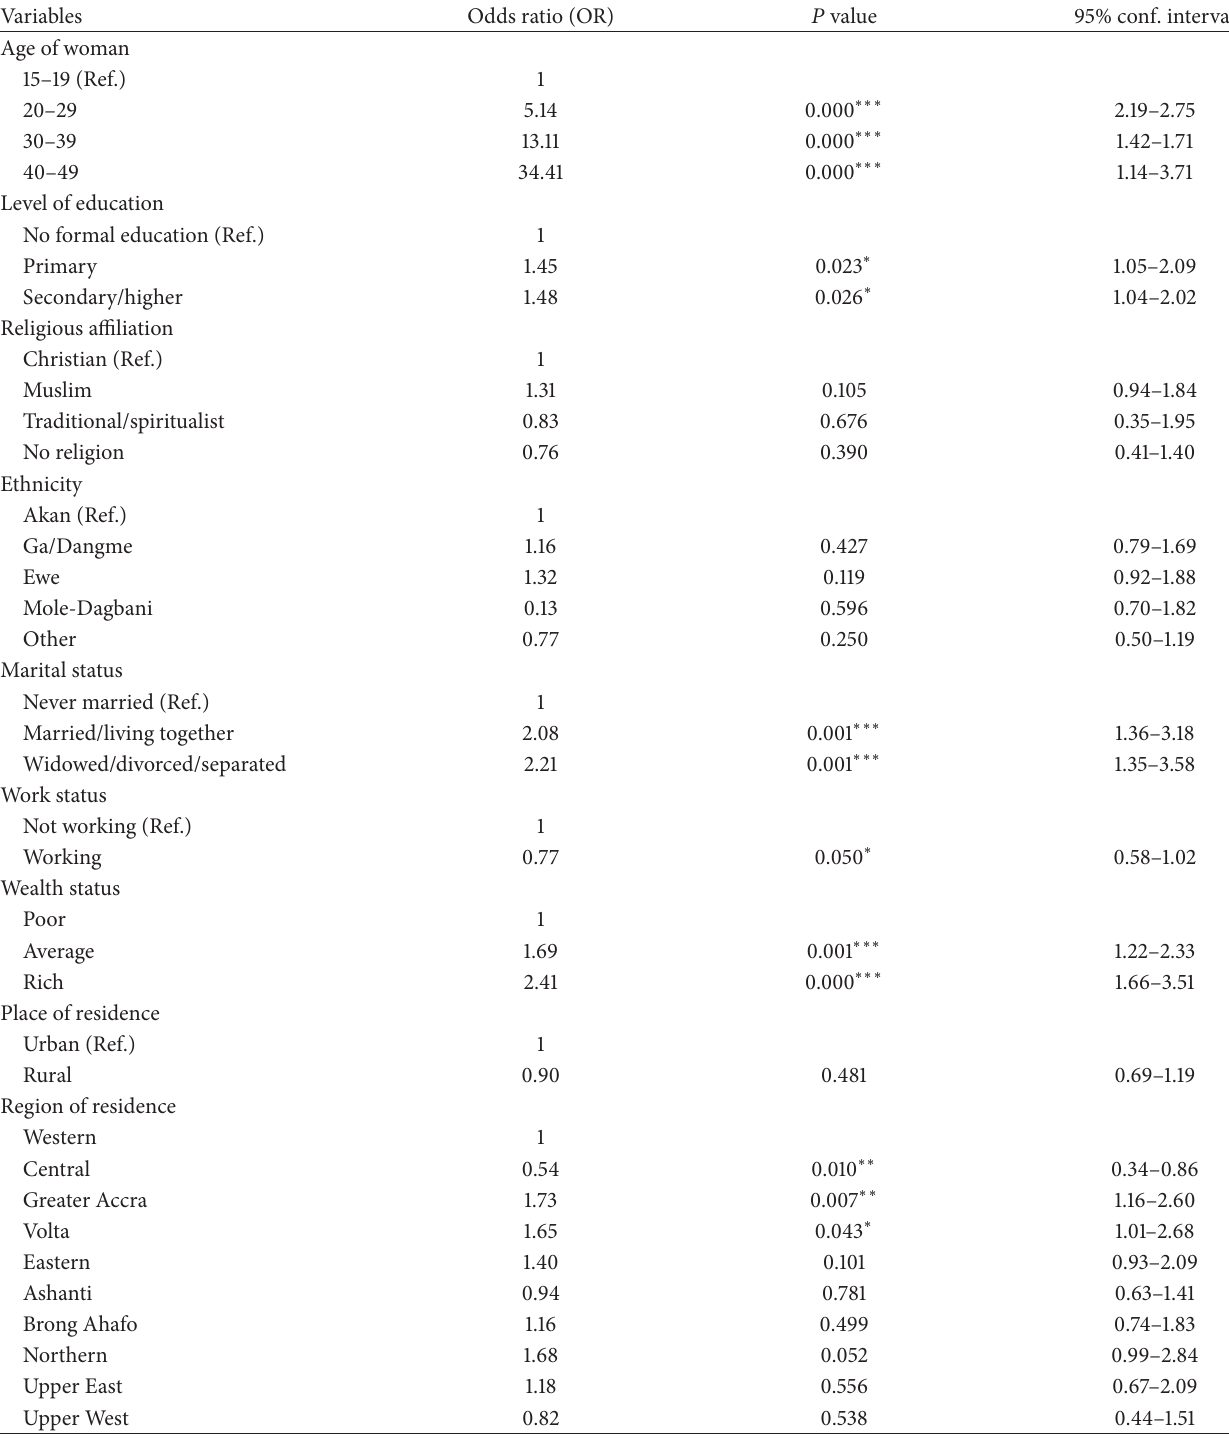
Table 2: Logistic regression of hypertension history among women aged